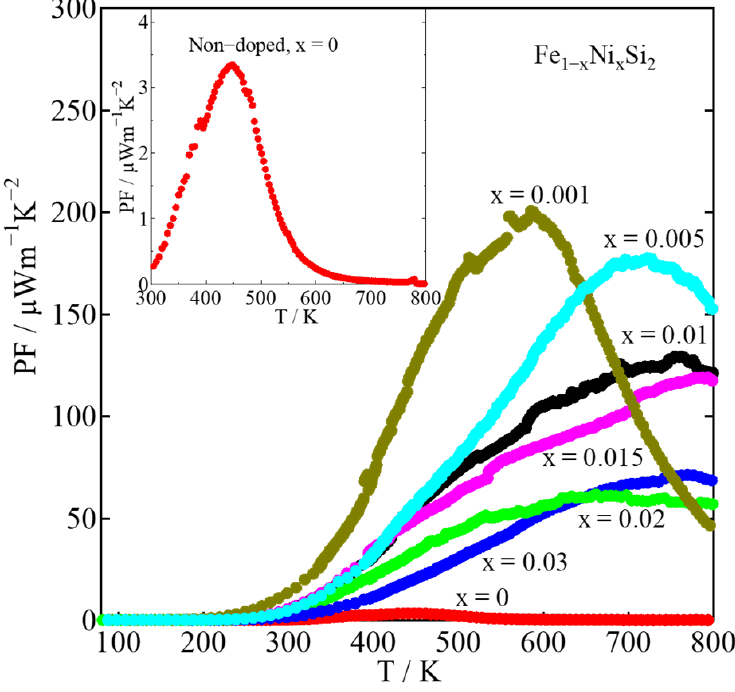
Figure 7. Power factor ( PF ) of β -Fe 1−x Ni x Si 2 (0 ≤ x ≤ 0.03) with respect to temperature, where the inset plots the data of x = 0.